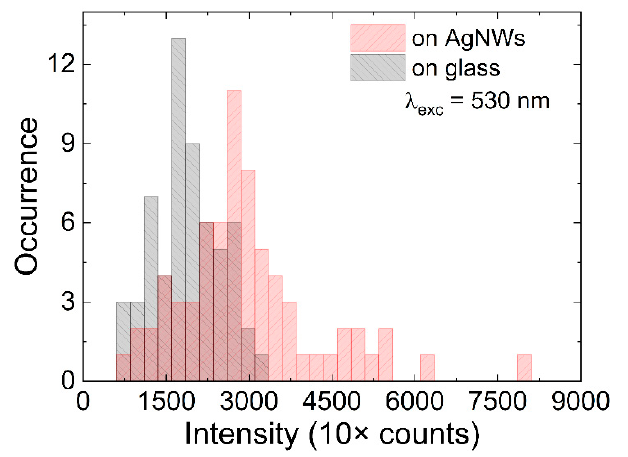
Figure 3. Histogram of fluorescence intensities of single mCherry proteins on AgNWs (red) and in the background on glass (black).